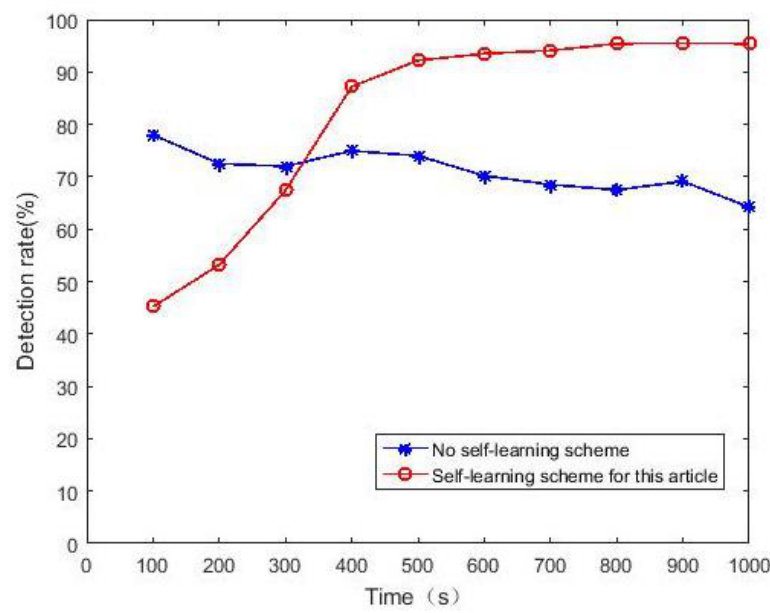
Figure 10. Comparison of different experimental protocols and detection rates.